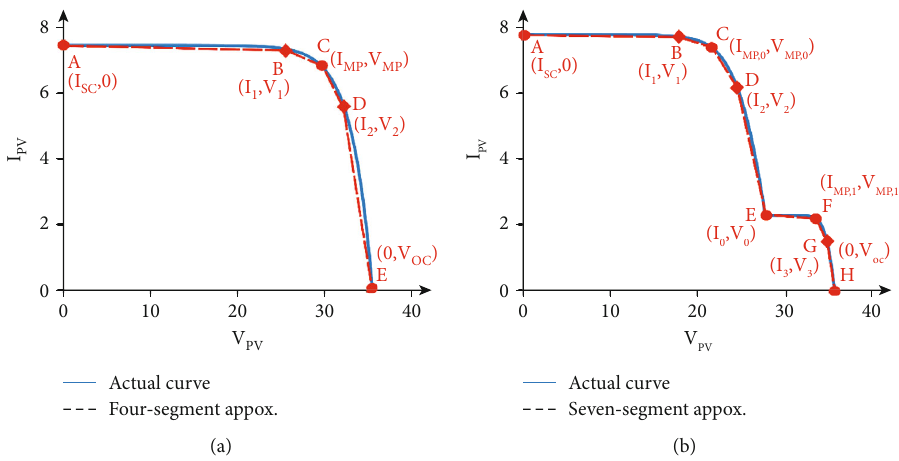
Figure 7: Piecewise linearization of I-V curves of (a) uniformly irradiated (b) partially shaded PV panel.